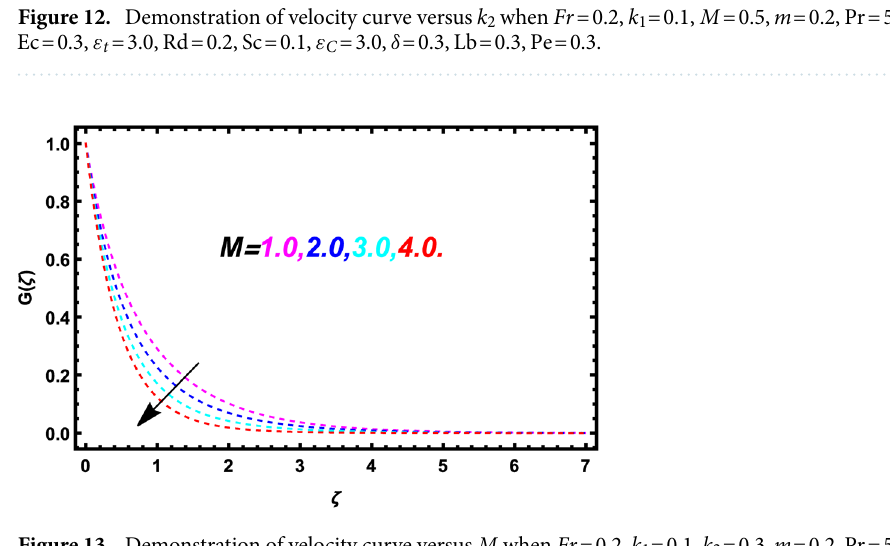
Figure 13. Demonstration of velocity curve versus M when Fr = 0.2, k 1 = 0.1, k 2 = 0.3, m = 0.2, Pr = 5.3, φ = 0.01, Ec = 0.3, ε Rd = 0.2, Sc = 0.1, ε Lb = 0.3, Pe = t = 3.0, C = 3.0, δ = 0.3,